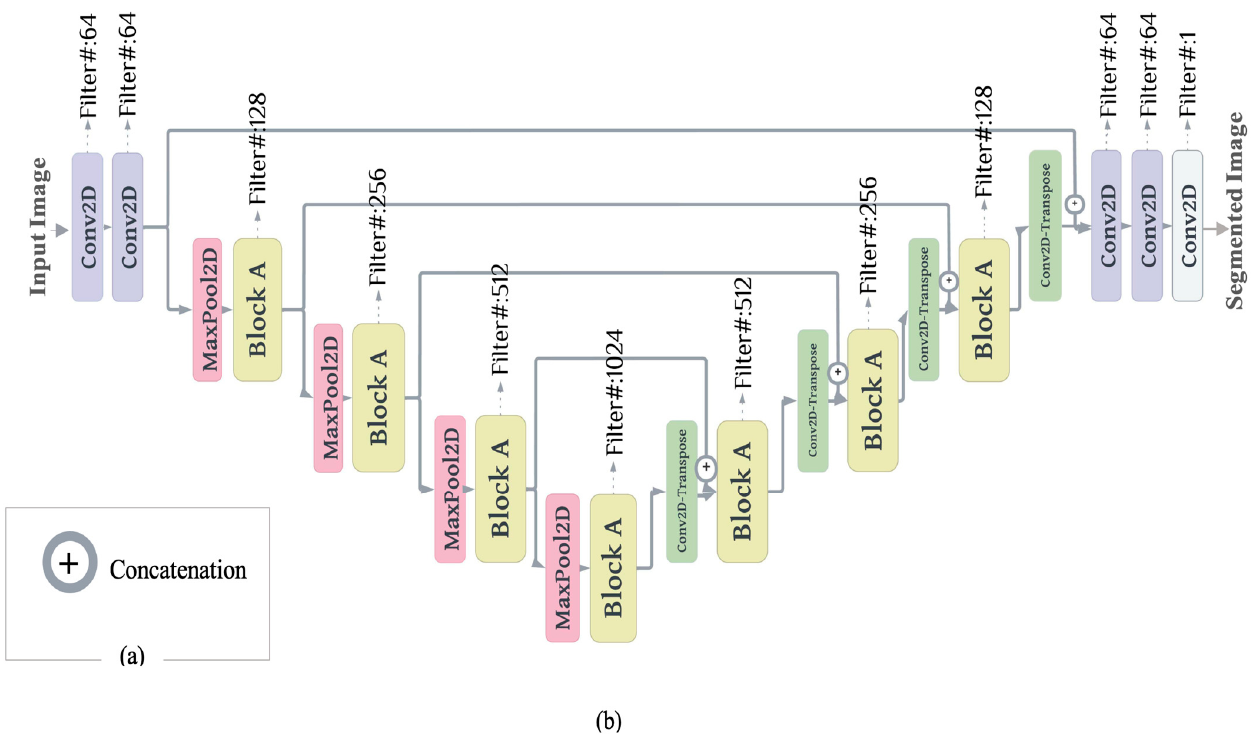
Figure 3. The proposed multiscale depth-wise separable U-Net. Block A is the proposed depth- separable block shown in Figure 2: ( a ) concatenation operation; and ( b ) the proposed multiscale depth-wise separable U-Net. The input image is progressively filtered and down-sampled by a factor of 2 at each layer in the contracting path on the left. The expansive path on the right performs up-sampling operations to reconstruct a binary-masked image. The number of filters at each layer is denoted on top of the block.